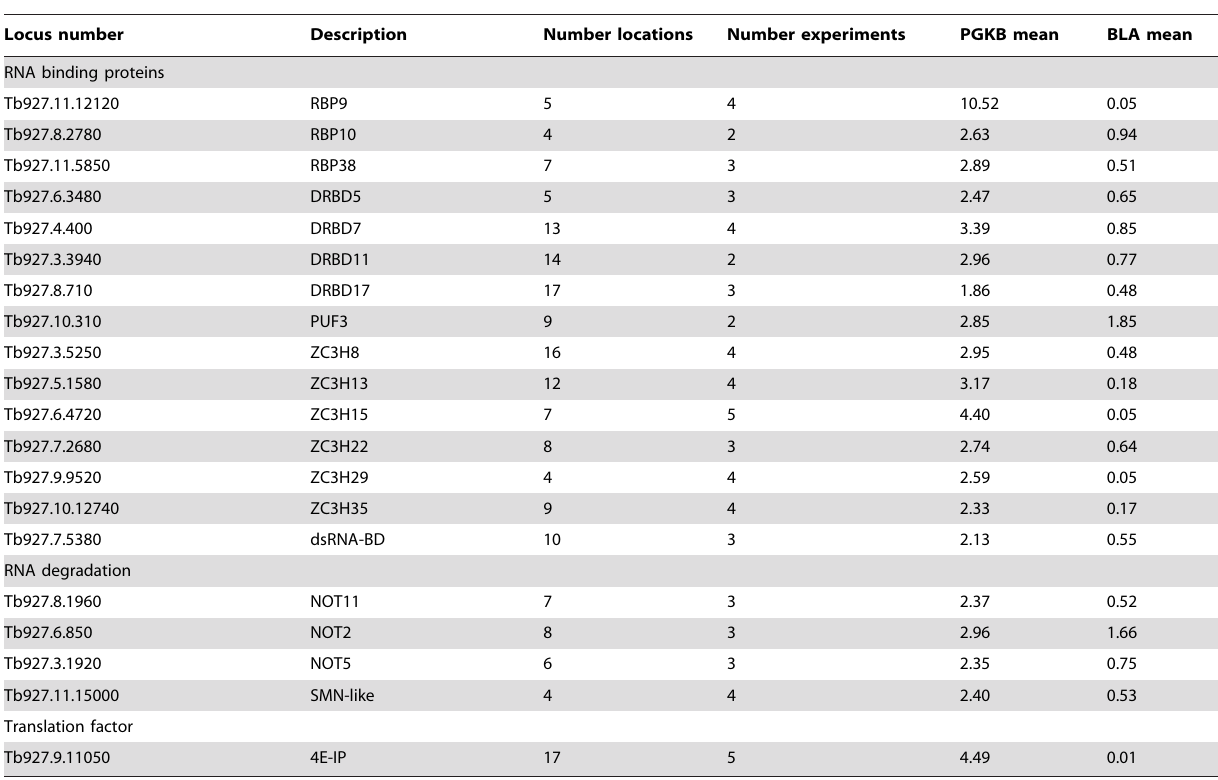
Table 2. Selected factors that suppress PGKB expression.